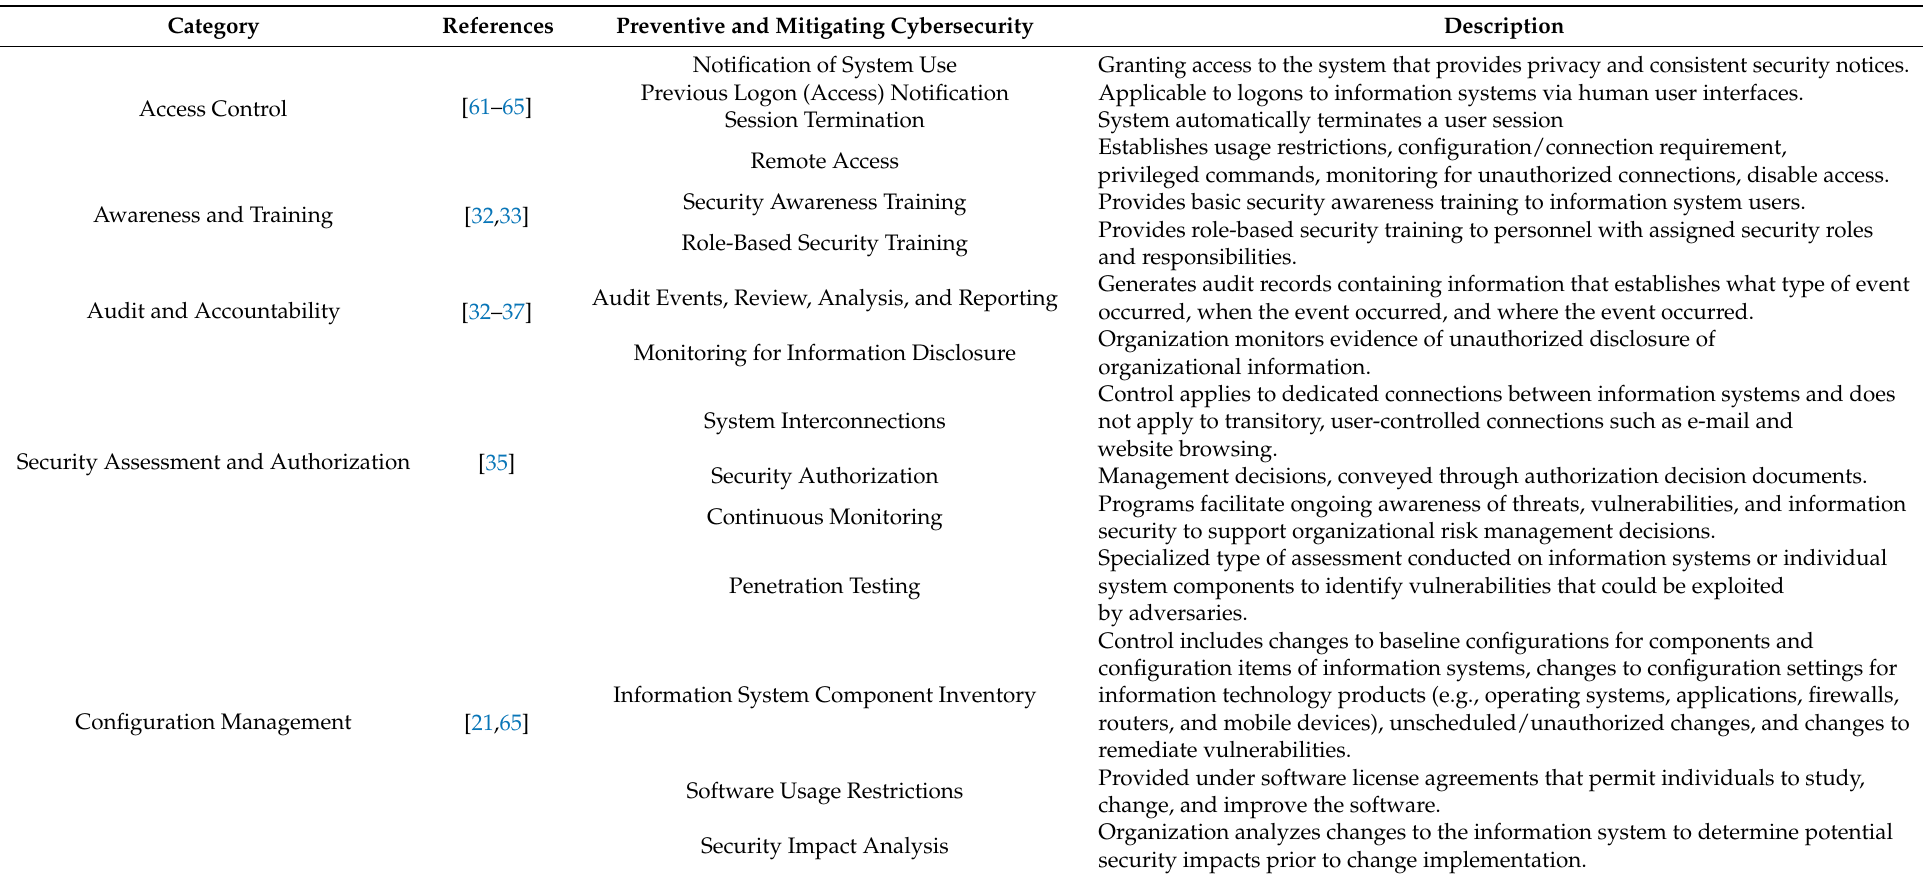
Table 3. Preventive and mitigating